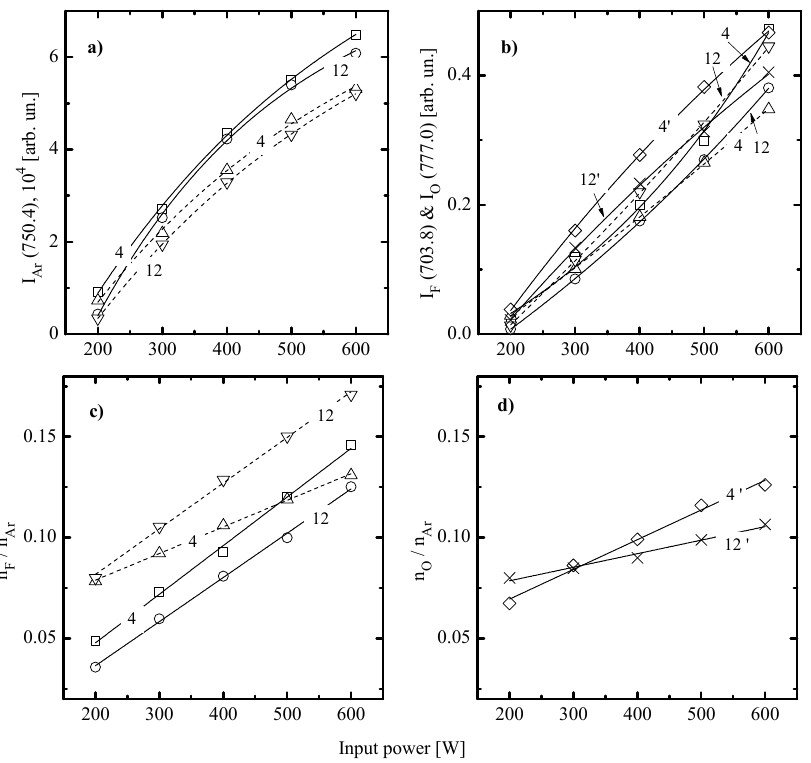
Figure 6. Optical emission spectroscopy (OES) diagnostics of 50% C 6 F 12 O + 50% Ar (solid lines) and 50% CF 4 + 50% Ar (dashed lines) plasmas: ( a ) measured emission intensity for Ar 750.4 nm line; ( b ) measured emission intensities for F 703.8 nm and O 777.0 nm lines; ( c ) evaluated n F / n Ar density ratio; and ( d ) evaluated n O / n Ar density ratio. Numerical labels on curves mean the gas pressure in mTorr while the «’» mark at the corresponding label points out on oxygen-related